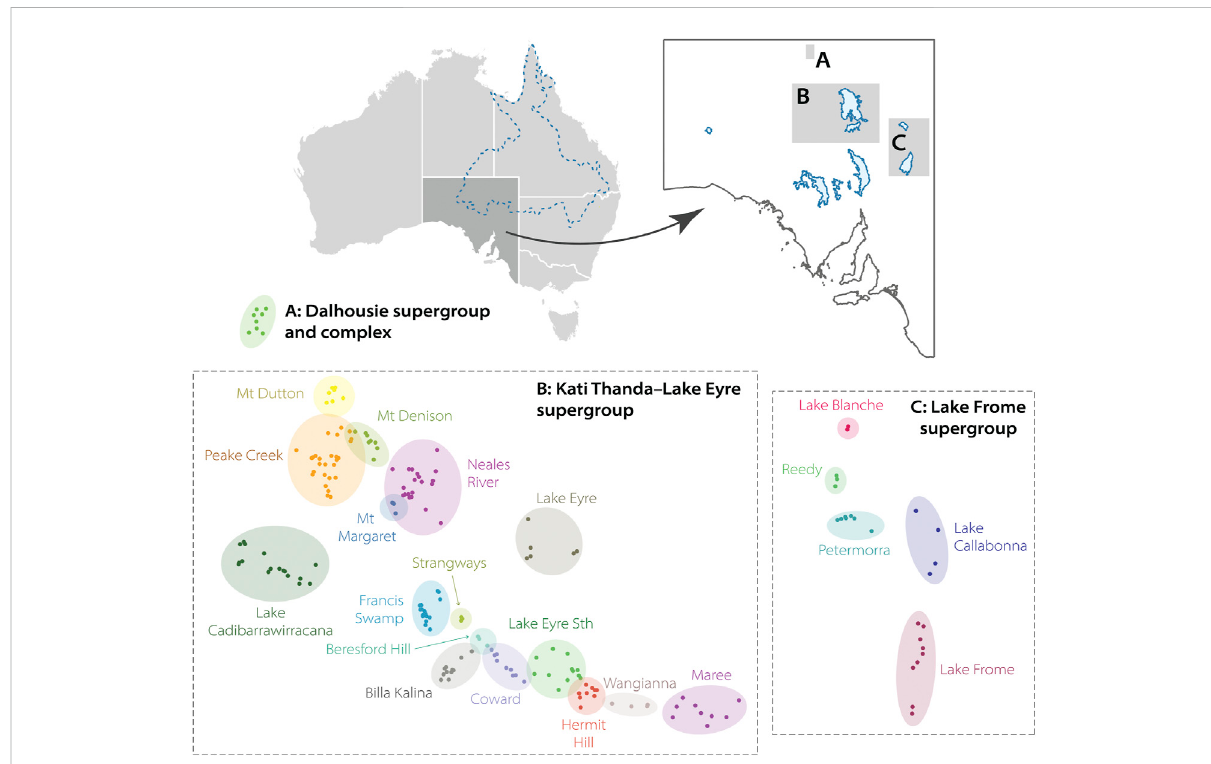
FIGURE 3 Location and naming of the three Great Artesian Basin (GAB) spring supergroups in South Australia following Lewis et al. (2013): (A) Dalhousie, (B) Kati Thanda – Lake Eyre, (C) Lake Frome. The approximate extent of the GAB is indicated top-left. Spring complexes (coloured circles) contain spring groups (points). The Maree complex is also referred to as Marree under certain classi fi